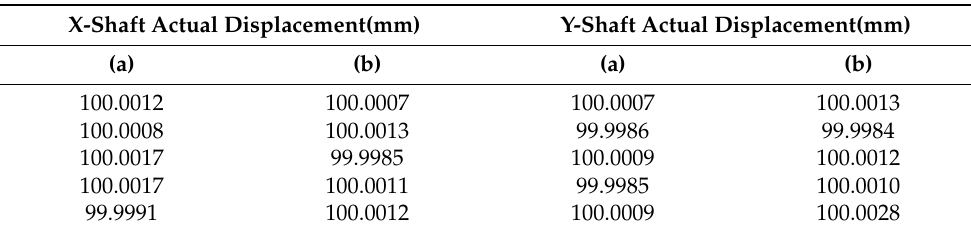
Table 6. Actual displacement distance of each shaft.